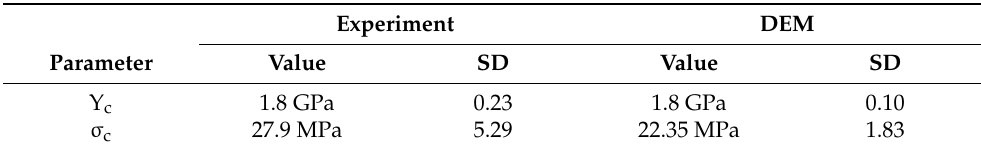
Table 2. Geotechnical parameters measured for the laboratory experiments and the calibrated numerical